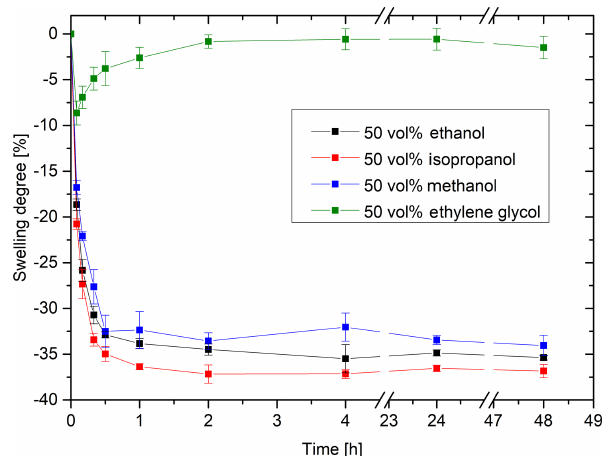
Figure 6. Swelling degree at different alcohol concentrations of ethanol, methanol and isopropanol (hydrogel: 10vol%Aam and